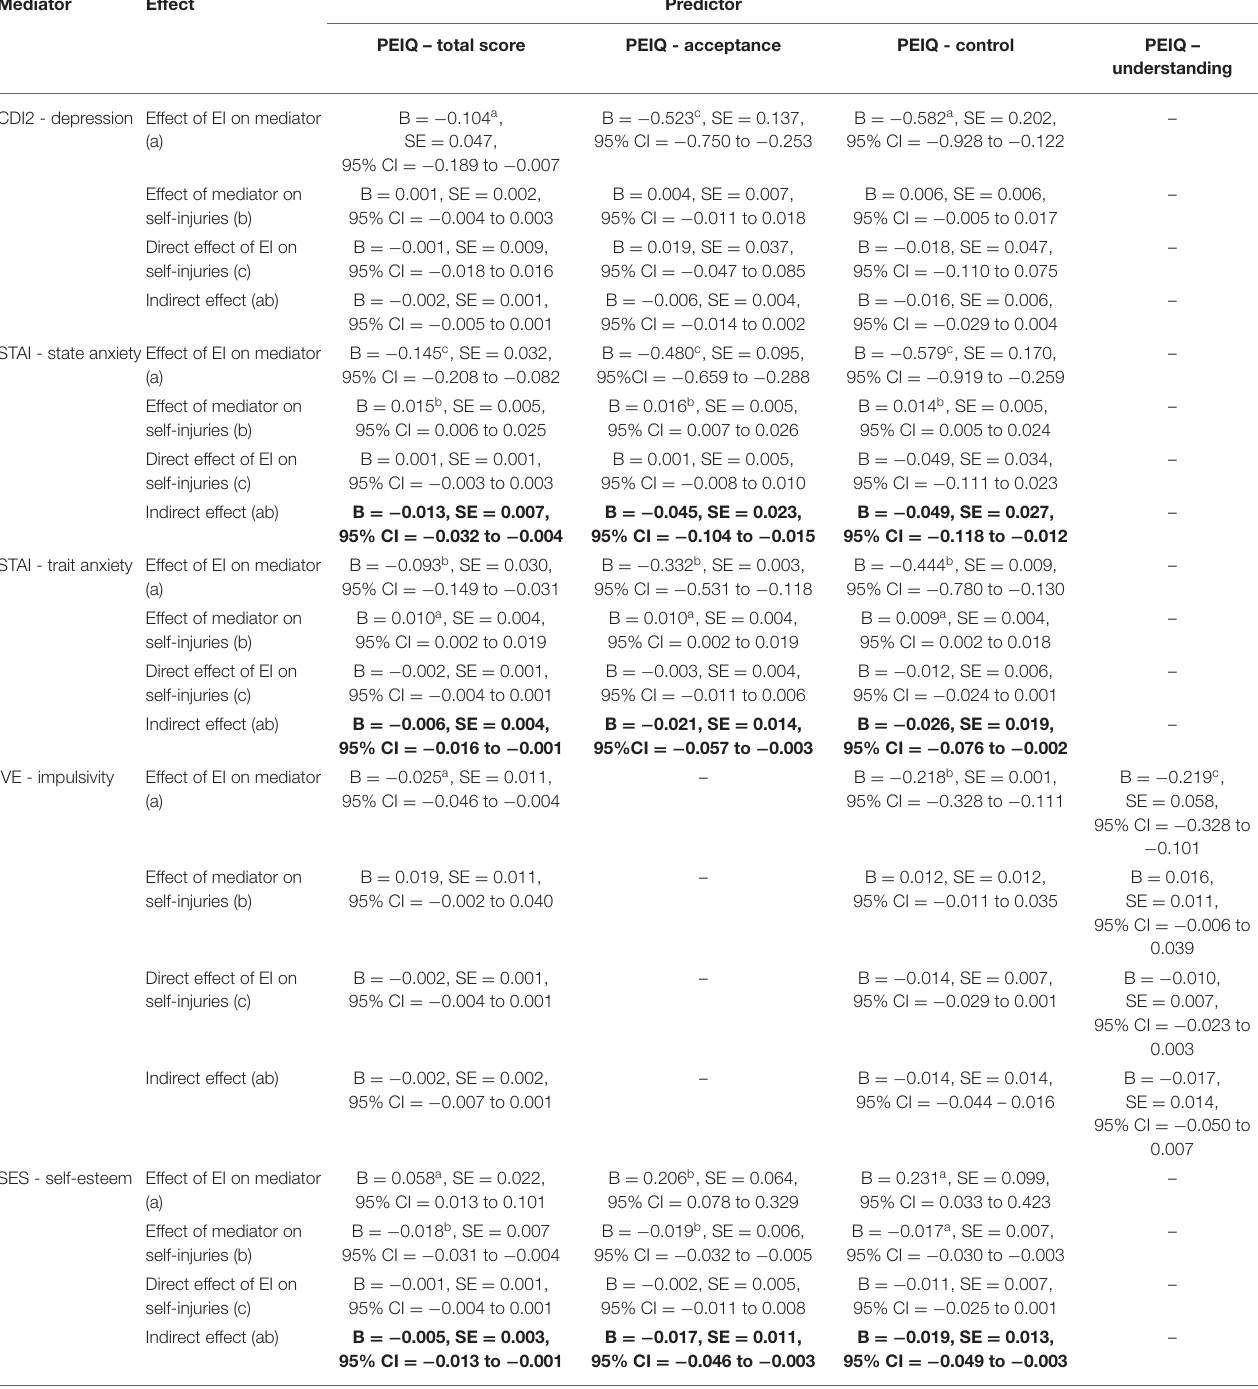
TABLE 3 | Results of mediation